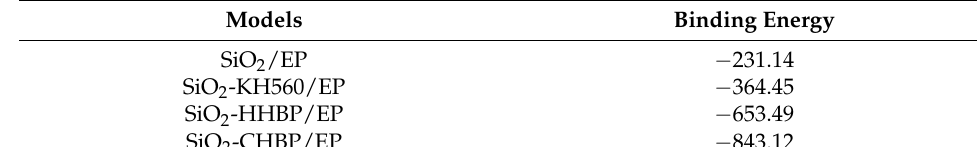
Table 6. The binding energy of five models (units: kcal/mol).